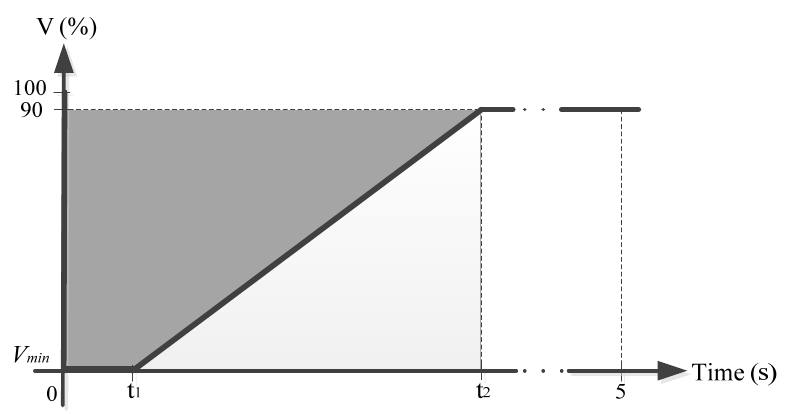
Figure 10. Energy required during LVRT, German